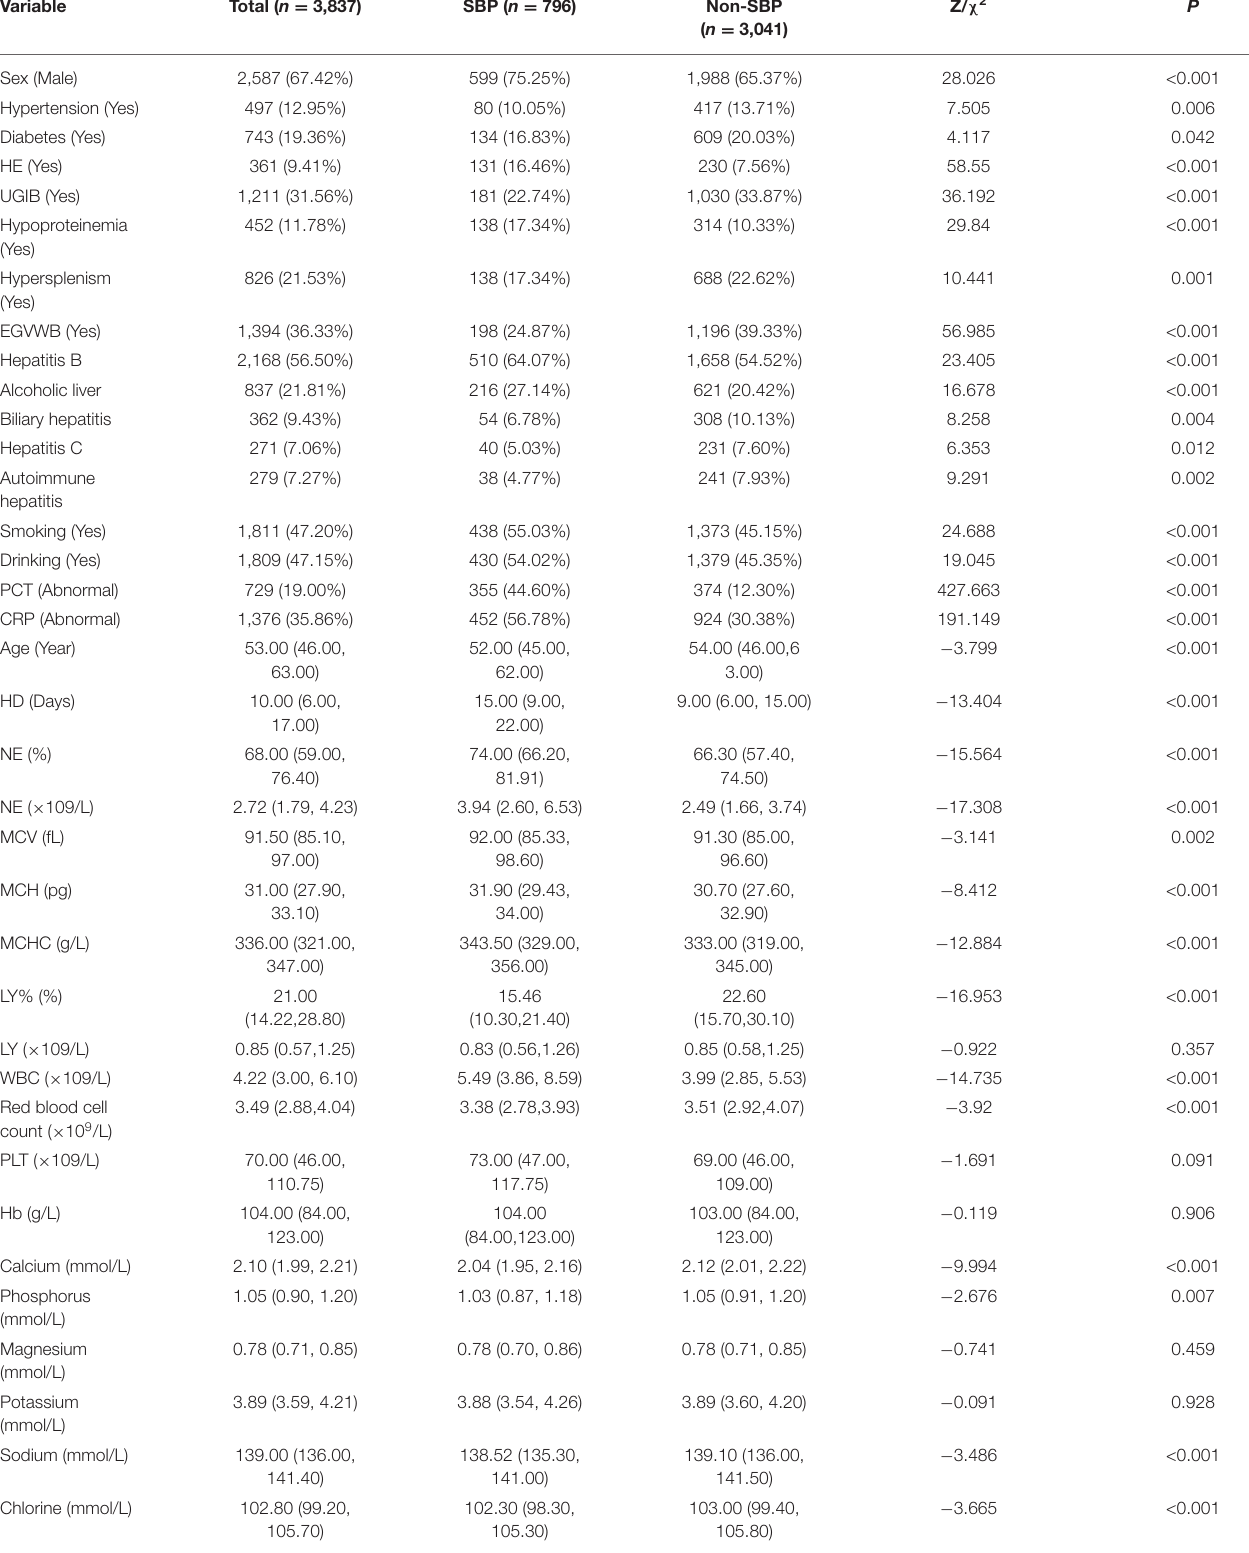
TABLE 1 | Characteristics of the participants in the SBP group and non-SBP group.